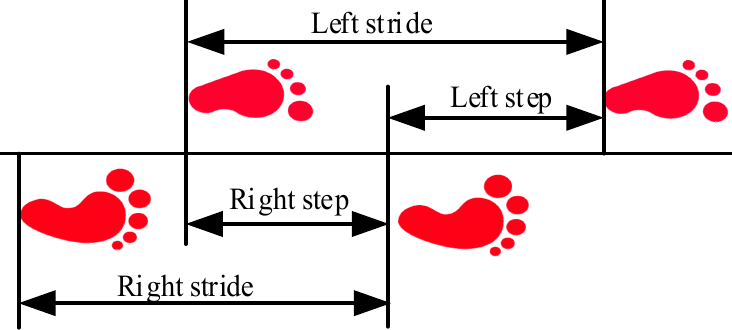
Figure 1. Strides are defined by the positions of two consecutive footfalls of the same foot, while the steps are defined by the positions of opposite feet.